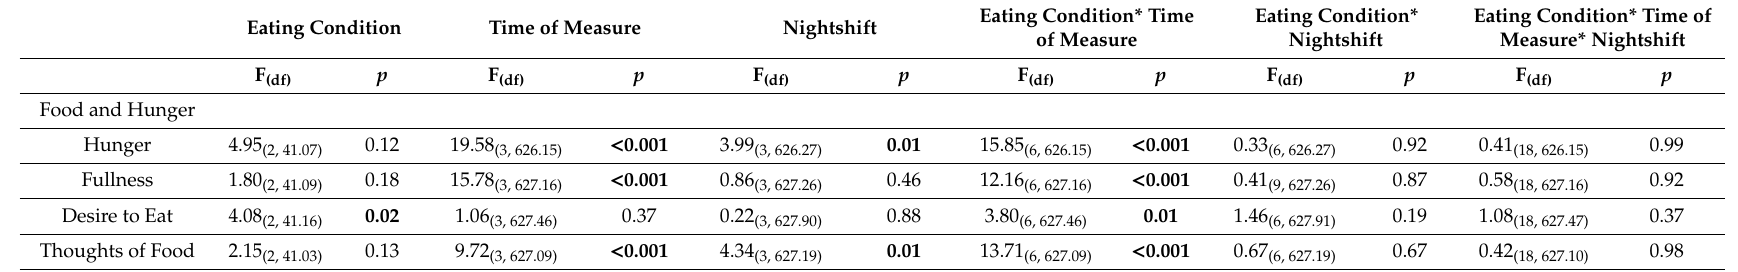
Table 1. Results from the mixed e ff ects Analysis of Variance (ANOVA) showing the main e ff ects of eating condition (MN, SN, NE), Time of measure (21:00, 23:30, 2:30, 5:00) and Nightshift (NS1-NS4), and the interaction e ff ects of eating condition by time of measure, eating condition by nightshift, and eating condition by time of measure by